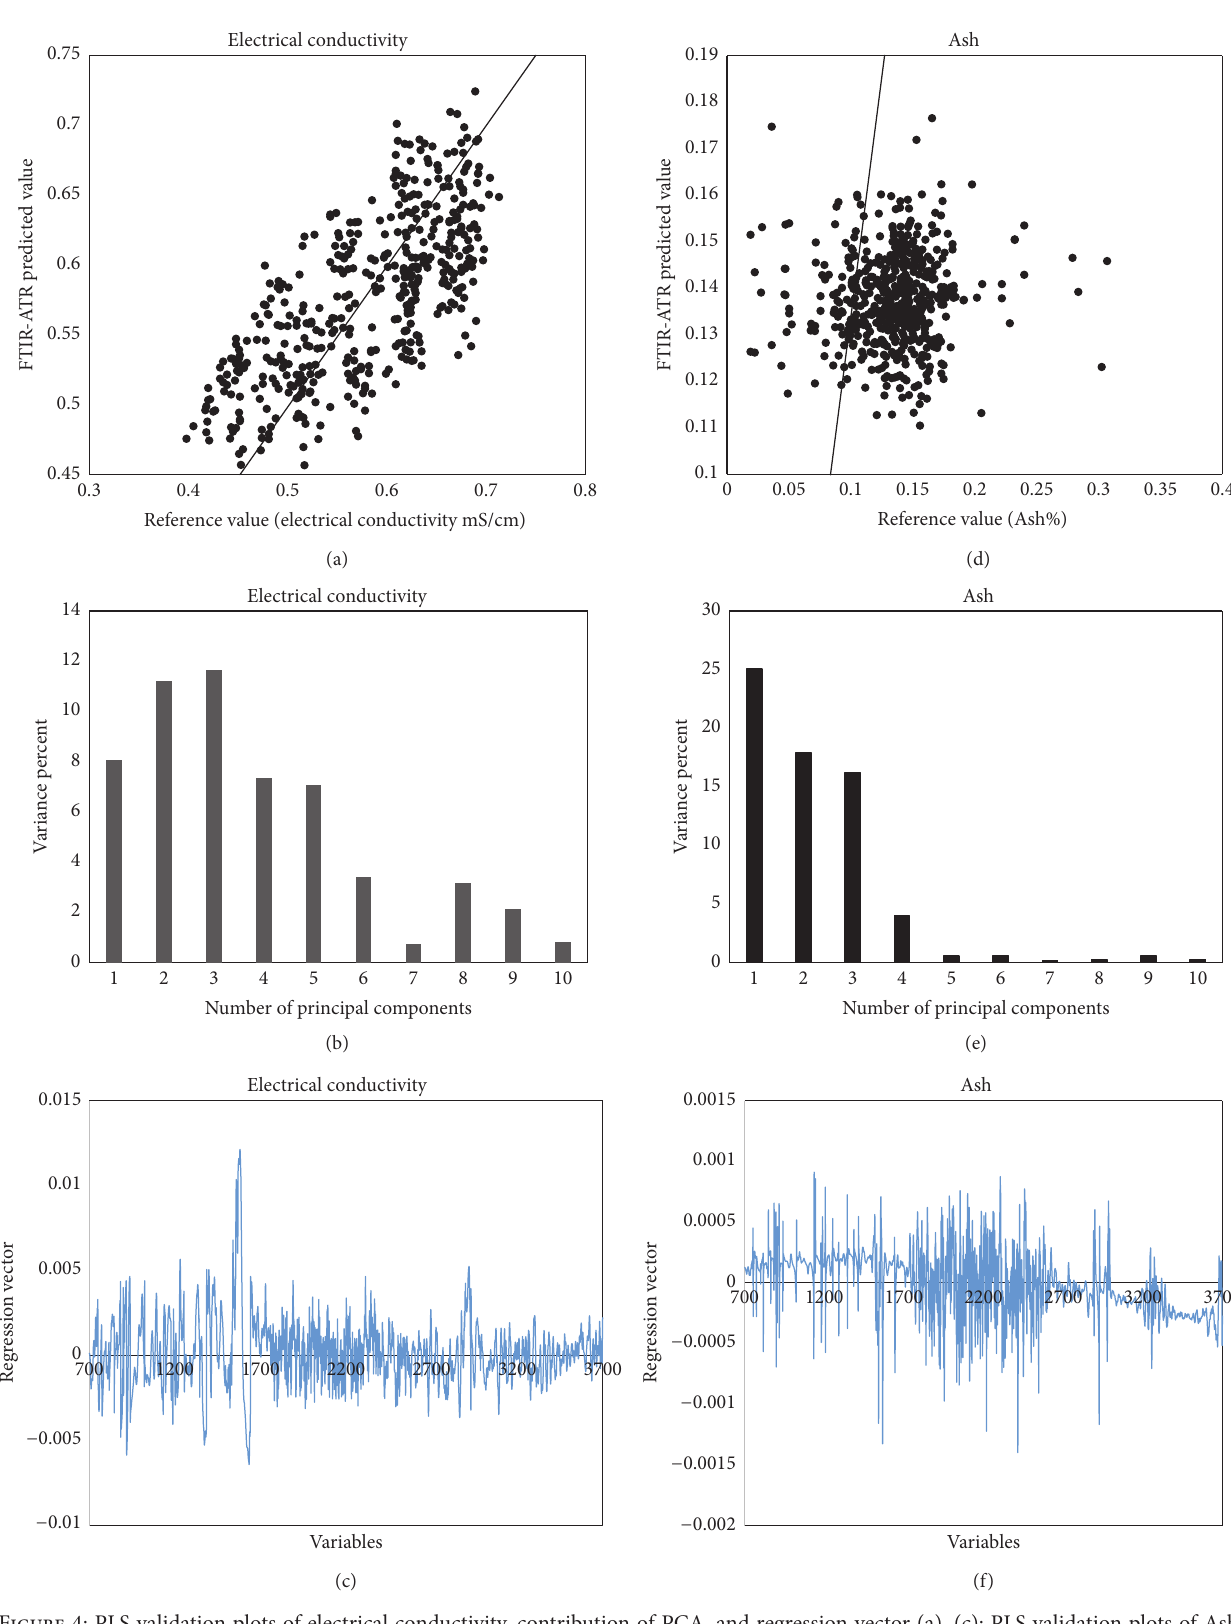
Figure 4: PLS validation plots of electrical conductivity, contribution of PCA, and regression vector (a)–(c); PLS validation plots of Ash, contribution of PCA, and regression vector